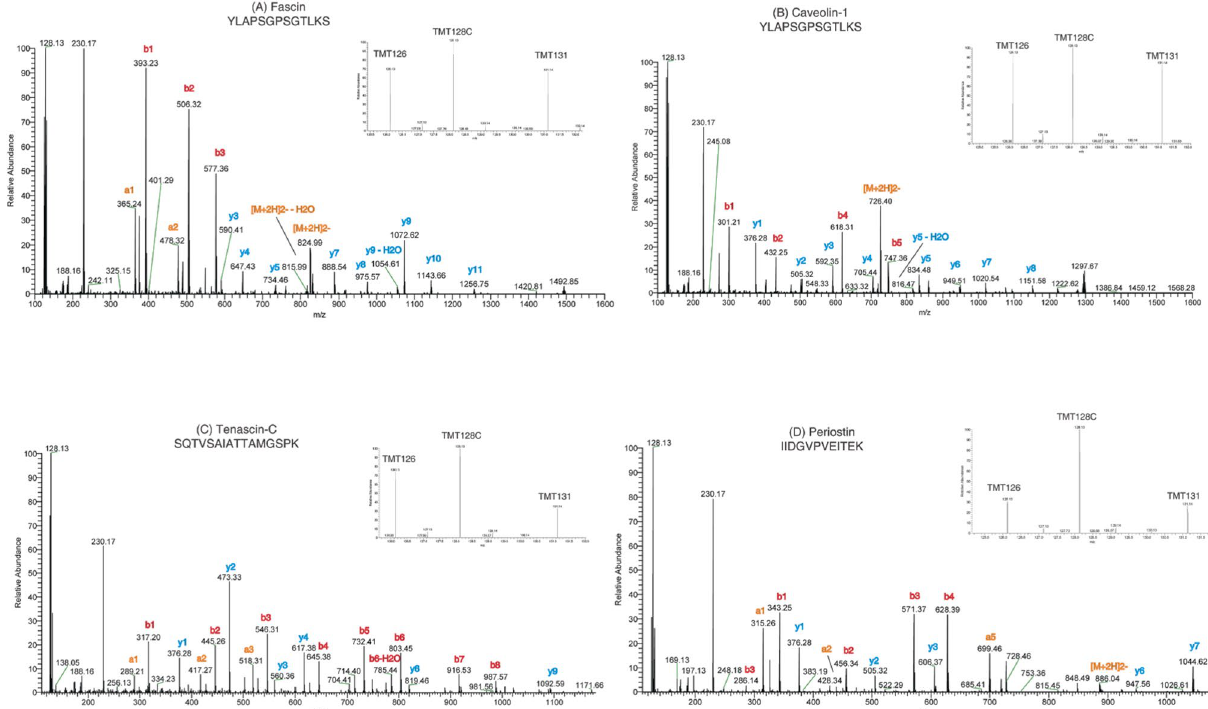
Figure 2. Representative MS/MS spectra of identified peptides from Periostin (POSTN); Tenascin c (TNC); Caveolin 1 (CAV1) and Fascin 1 (FSCN1). The MS spectra in the inset provides the relative abundance with Tandem Mass Tags (TMTs) of the representative